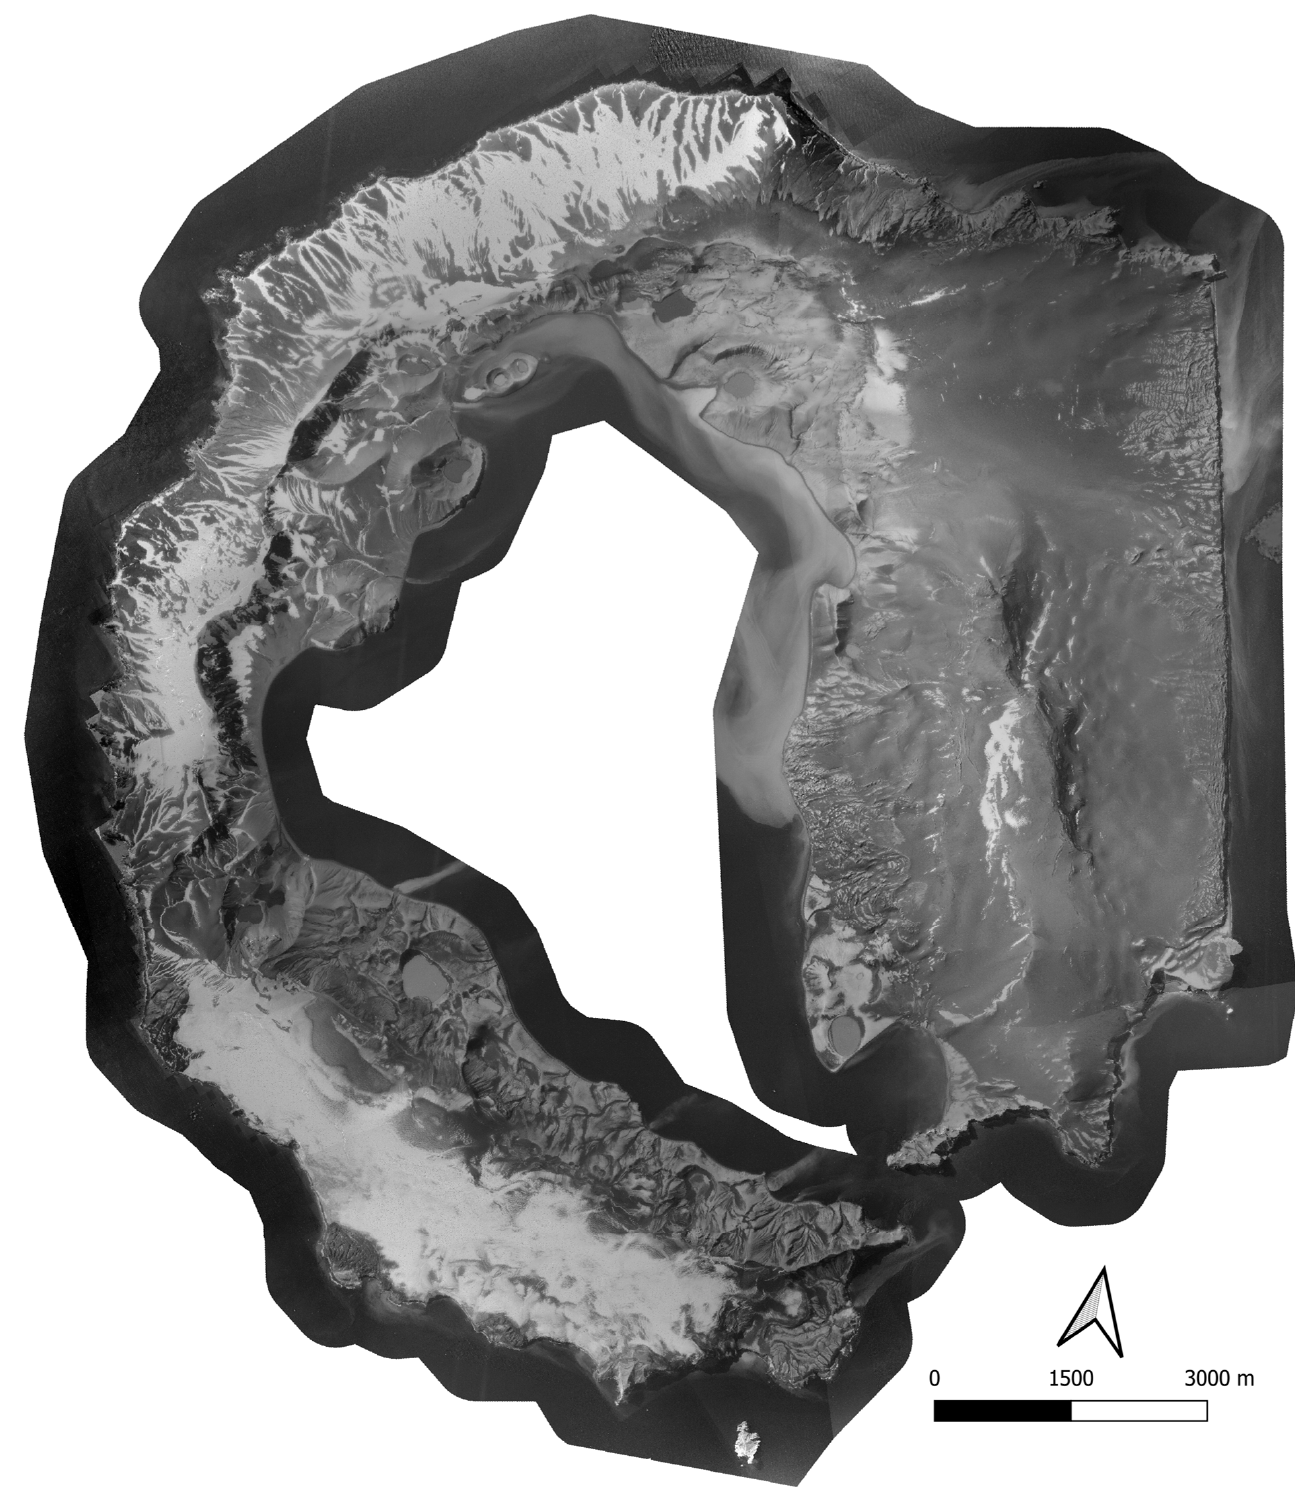
Figure 3. Orthographic mosaic of 1968 after the 1967 eruption ended, in black and white and corrected with the computed digital elevation model using SfM–MvS strategies. The 1968 stereo pairs were supplemented by those from 1956 without clouds in areas geomorphologically unchanged by the 1967 eruption, raising the degree of overlap and digital elevation model precision, which, together with the historical aerial frames of 1968, generated this orthographic mosaic.